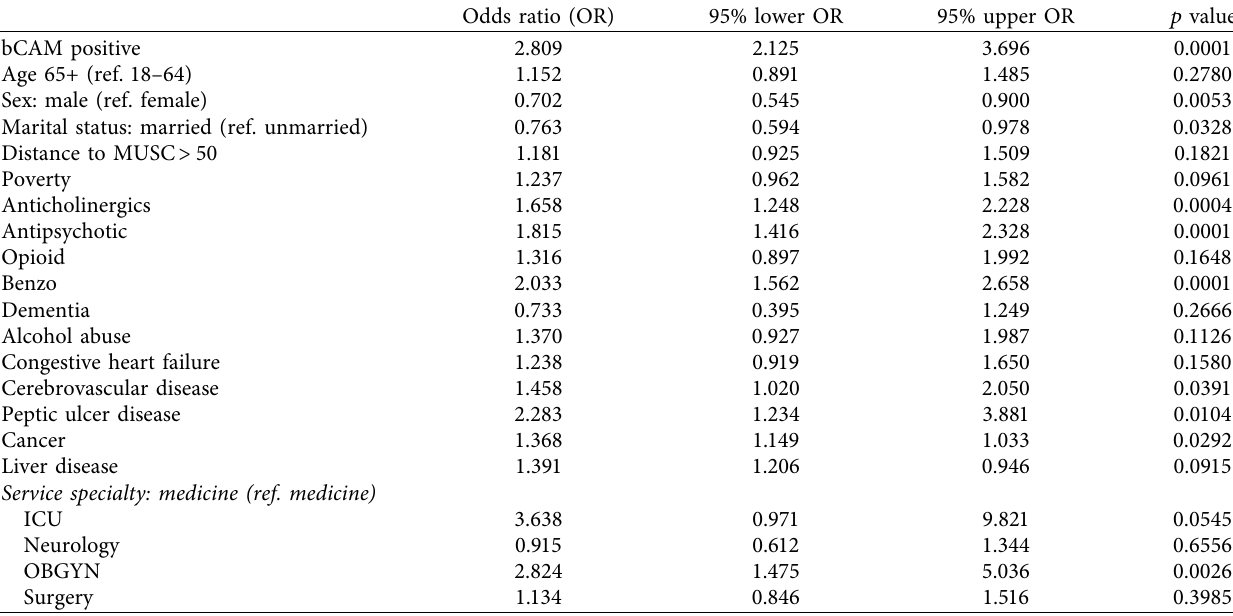
Table 3: Multivariable logistic regression adjusted odds ratio for